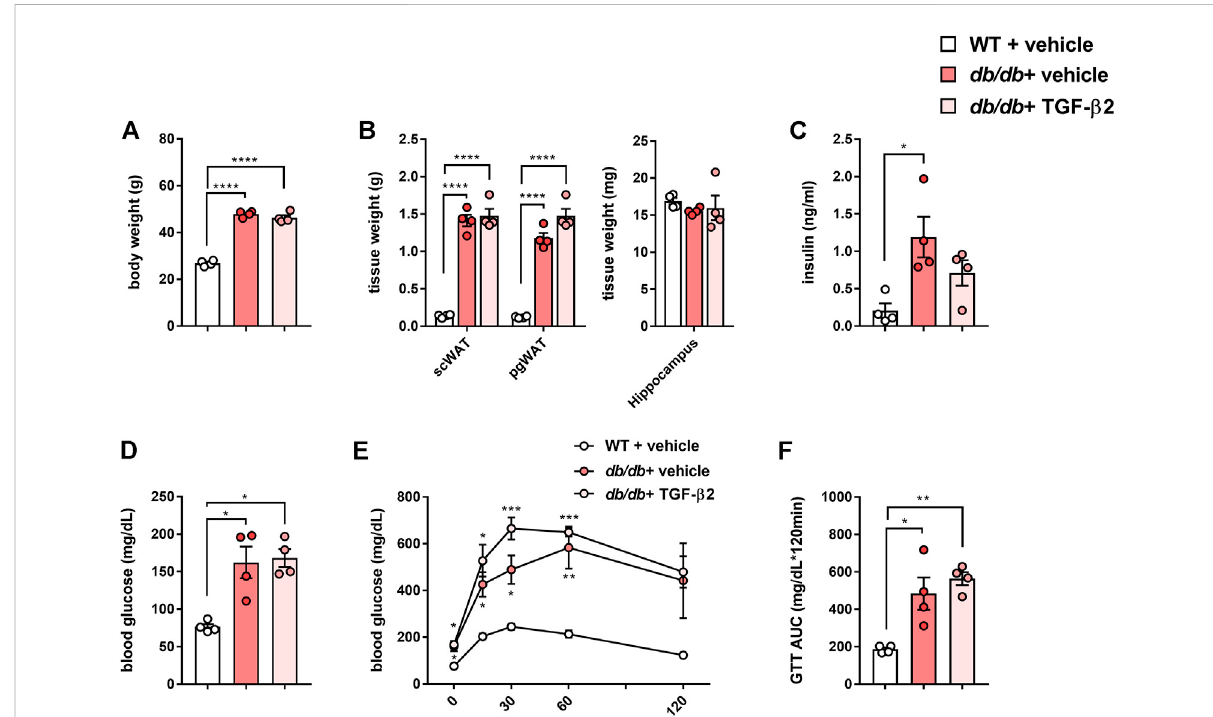
FIGURE 1 TGF- β 2 infusion has no effects on the body mass gain or glucose tolerance of db/db mice (A) Body mass (B) scWAT, pgWAT, and hippocampal masses, (C) fasting serum insulin concentration (D) blood glucose concentration, (E) results of glucose tolerance testing, and (F) area under the glucose curve (AUC) for WT, db/db + vehicle, and db/db + TGF- β 2 mice. Data are presented as the mean ± SE ( n = 4/group). The dots represent individual data points. **** p < 0.0001; *** p < 0.001; ** p < 0.01; * p <